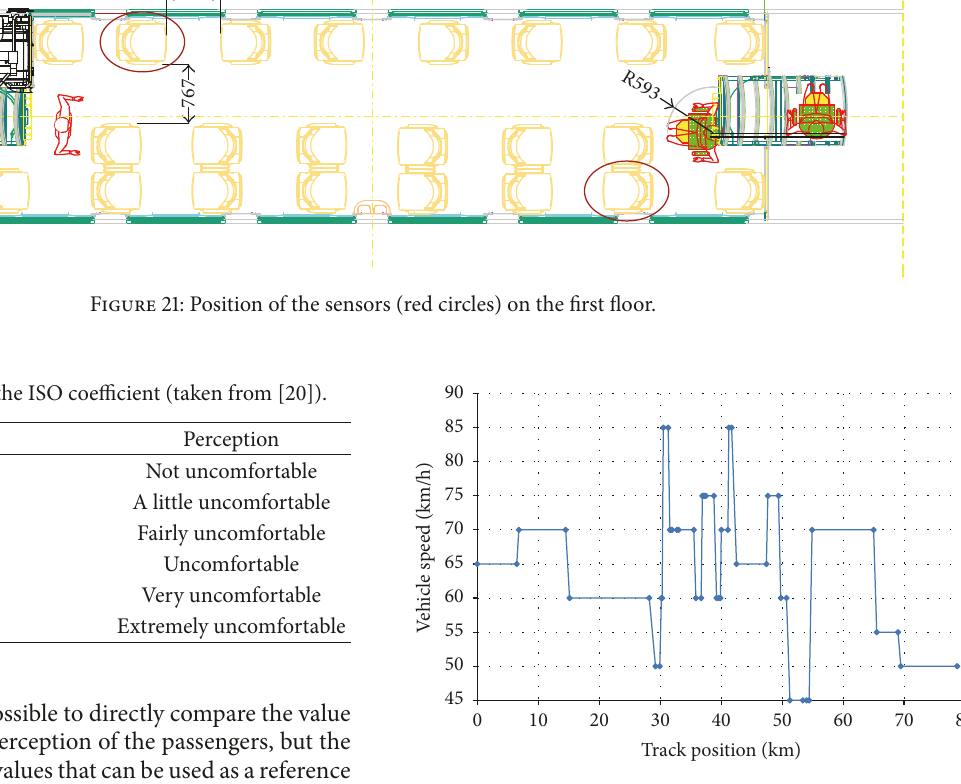
Figure 22: Speed profile of the vehicle during the